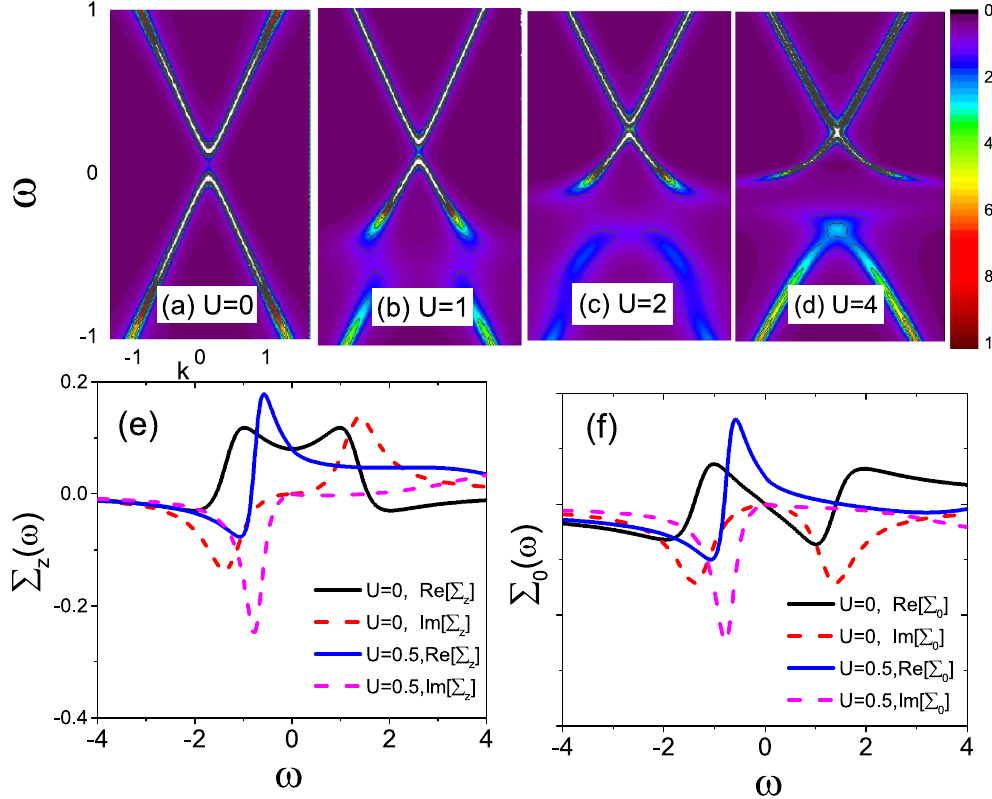
Figure 4. ( a – d ) Evolution of energy dispersion with impurity potential U = 0, 1, 2, 4 for gapped surface states. Dependence of (e) ∑ z ( ω ) and (f) ∑ 0 ( ω ) on U . The magnetic potential is chosen as M = 0.8 and the other parameters are the same as in Fig.